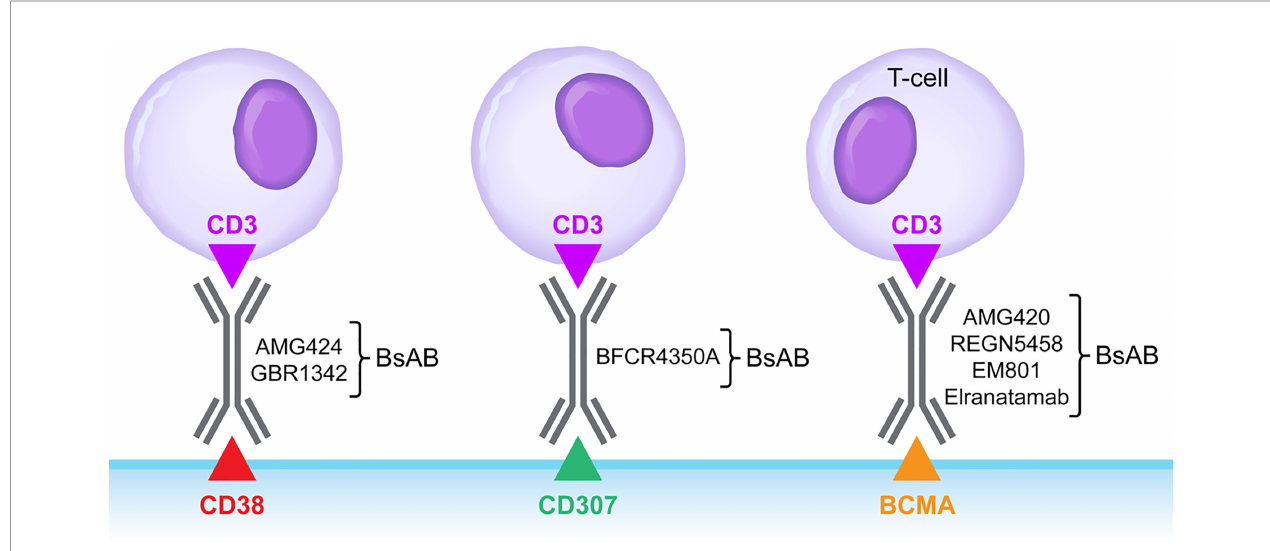
FIGURE 2 | Bispeci fi c Antibodies targeting MM cells. BsAB, bispeci fi c